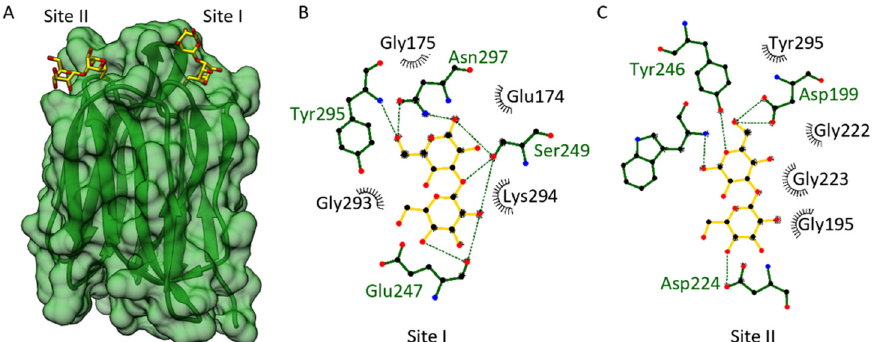
Figure 4. Docking of laminaribiose to the JRL domain of Os JAC1. ( A ) Transparent surface view of Os JAC1-JRL (cf1 chain A, green ribbon) with the two proposed binding sites (site I and site II) for laminaribiose (stick representation, carbon colored yellow). ( B , C ) Ligand interaction schemes (generated using LigPlot + [36]), indicating the residues involved in site I and site II, respectively. Hydrogen bonds are shown in green and hydrophobic interactions in black. The ligand laminaribiose is represended in yellow bonds, protein residues are shown in green.